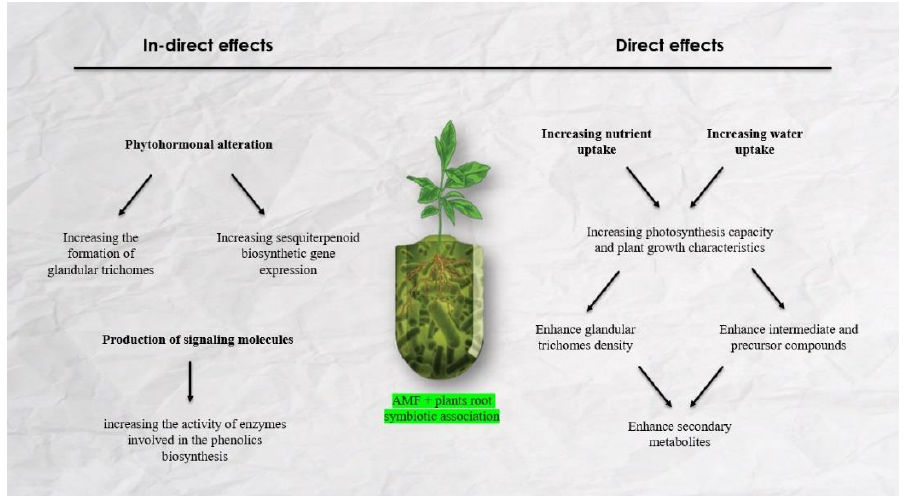
Figure 1. The direct and indirect effects of AMF symbiosis with plant roots on the production of secondary metabolites.